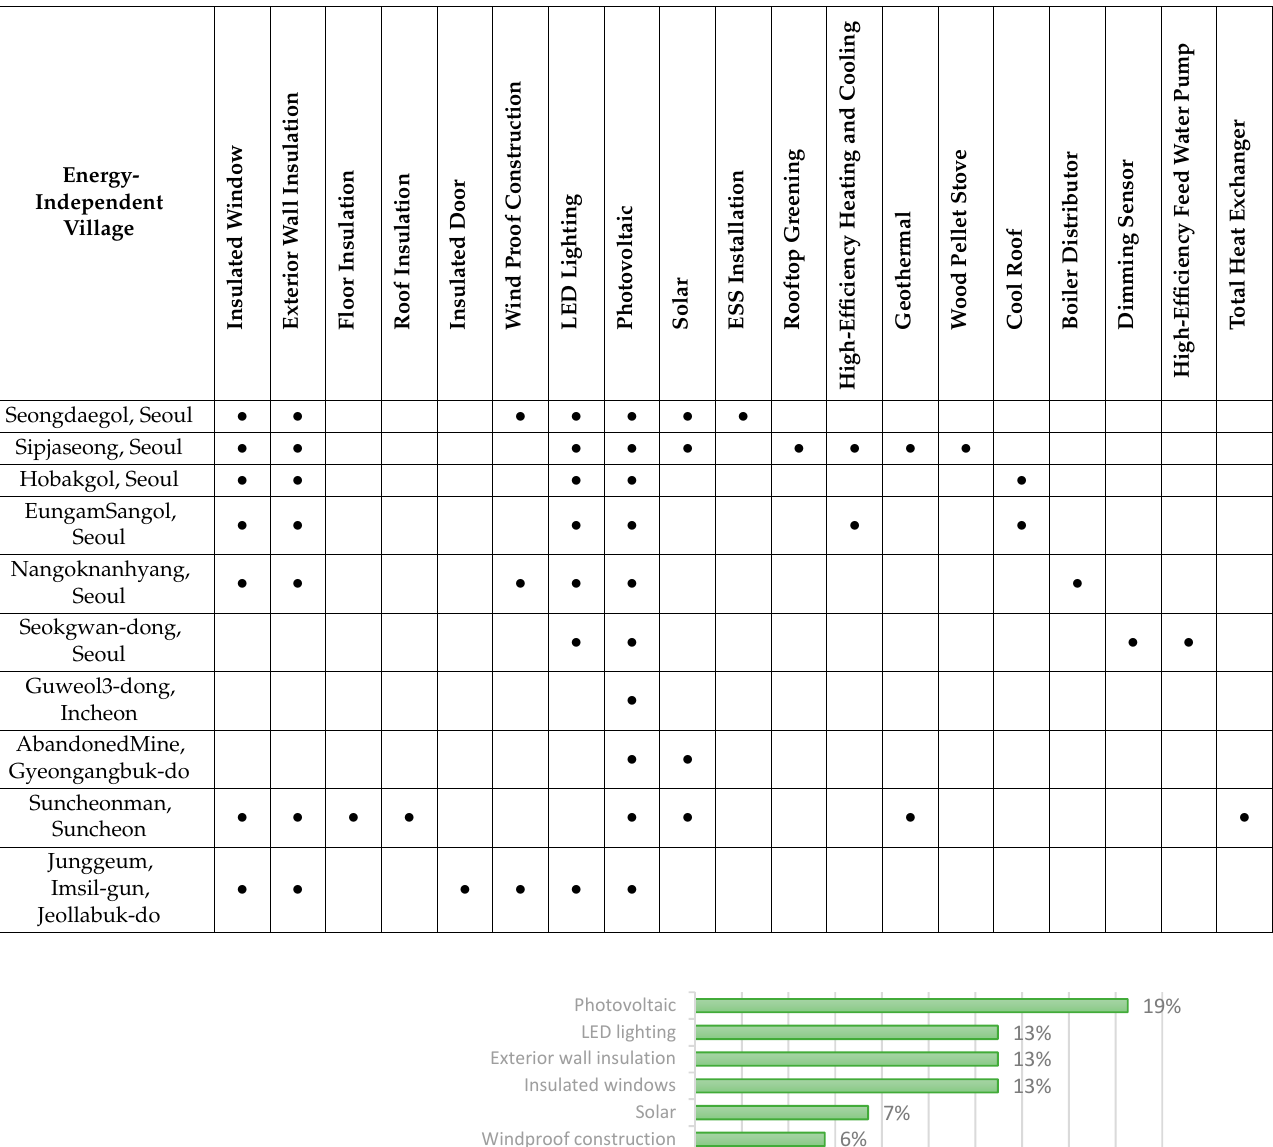
Table 2. Cases of the applied technologies for green remodeling of aging buildings in urban regeneration areas in South Korea [13,14].